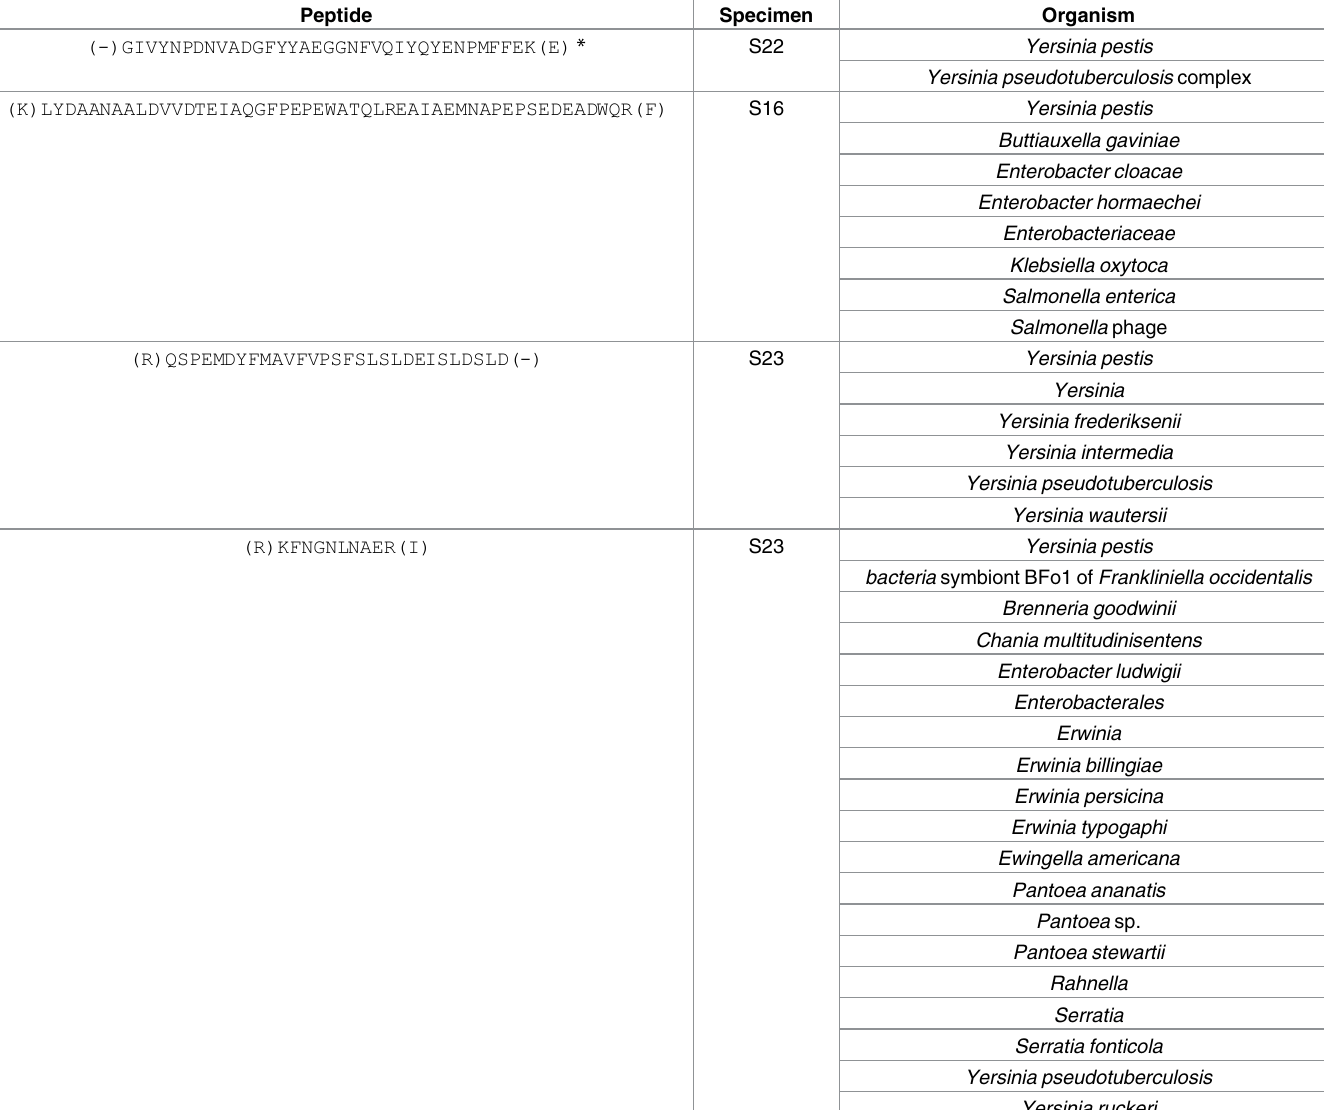
Table 2. List of four peptides retrieved from three individuals in a documented 18 th century plague site, France; exhibiting 100% identity and 100% coverage(Blast on NCBI) with at least Y . pestis . * This peptidewas found twice in the S22 individual.